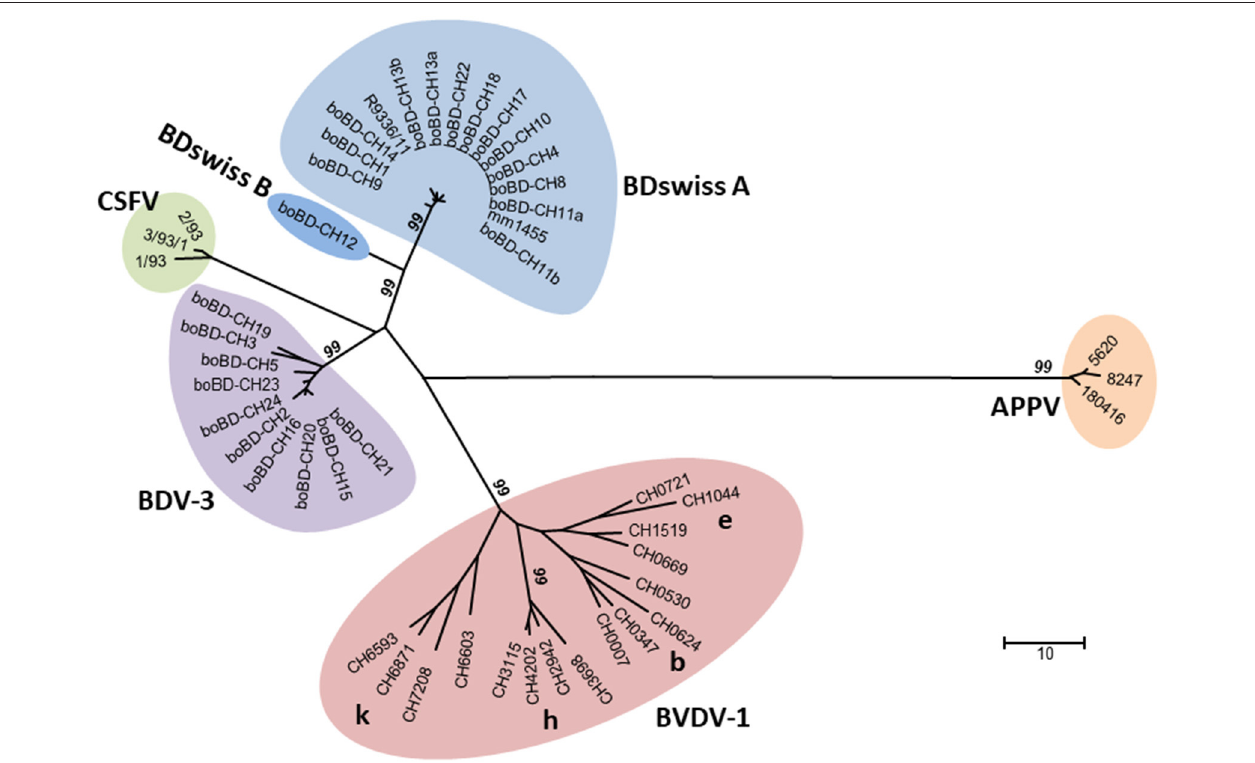
FIGURE 2 | Phylogenetic analysis of nucleotide sequences encompassing the 5’-UTR of the pestiviral RNA genome. All the major sub-genotypes of pestiviruses described in Switzerland are included in the tree, i.e., BDV-3 and BDswiss (BDV-8) with samples from this study, representative samples of BVDV-1b, -1e, -1h, and -1k (21), strains of atypical porcine pestiviruses found in domestic pigs in Switzerland (29), and strains of classical swine fever virus isolated in Switzerland in the last outbreak in wild boars around the year 2000 (31). The evolutionary history was inferred using the neighbour-joining method. The genetic analysis was calculated, and the figure prepared as described in Supplementary Table 7 . The numbers close to the branches represent the values (%) of 1,000 bootstrap replicates, and only values ≥ 99 are indicated. Line lengths are proportional to genetic distance and are in the units of the number of base differences per sequence, as indicated by the scale